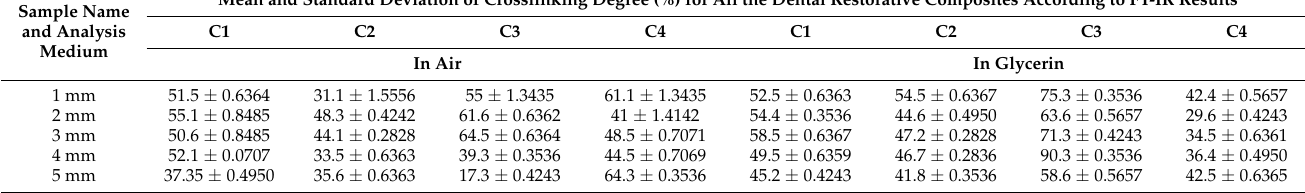
with the area band of the nonpolymerizable C=O group that is observed in each investi- Table 2. Comparison between the crosslinking degree values for all the restorative materials using both air and glycerin as polymerization medium at different distances from the curing